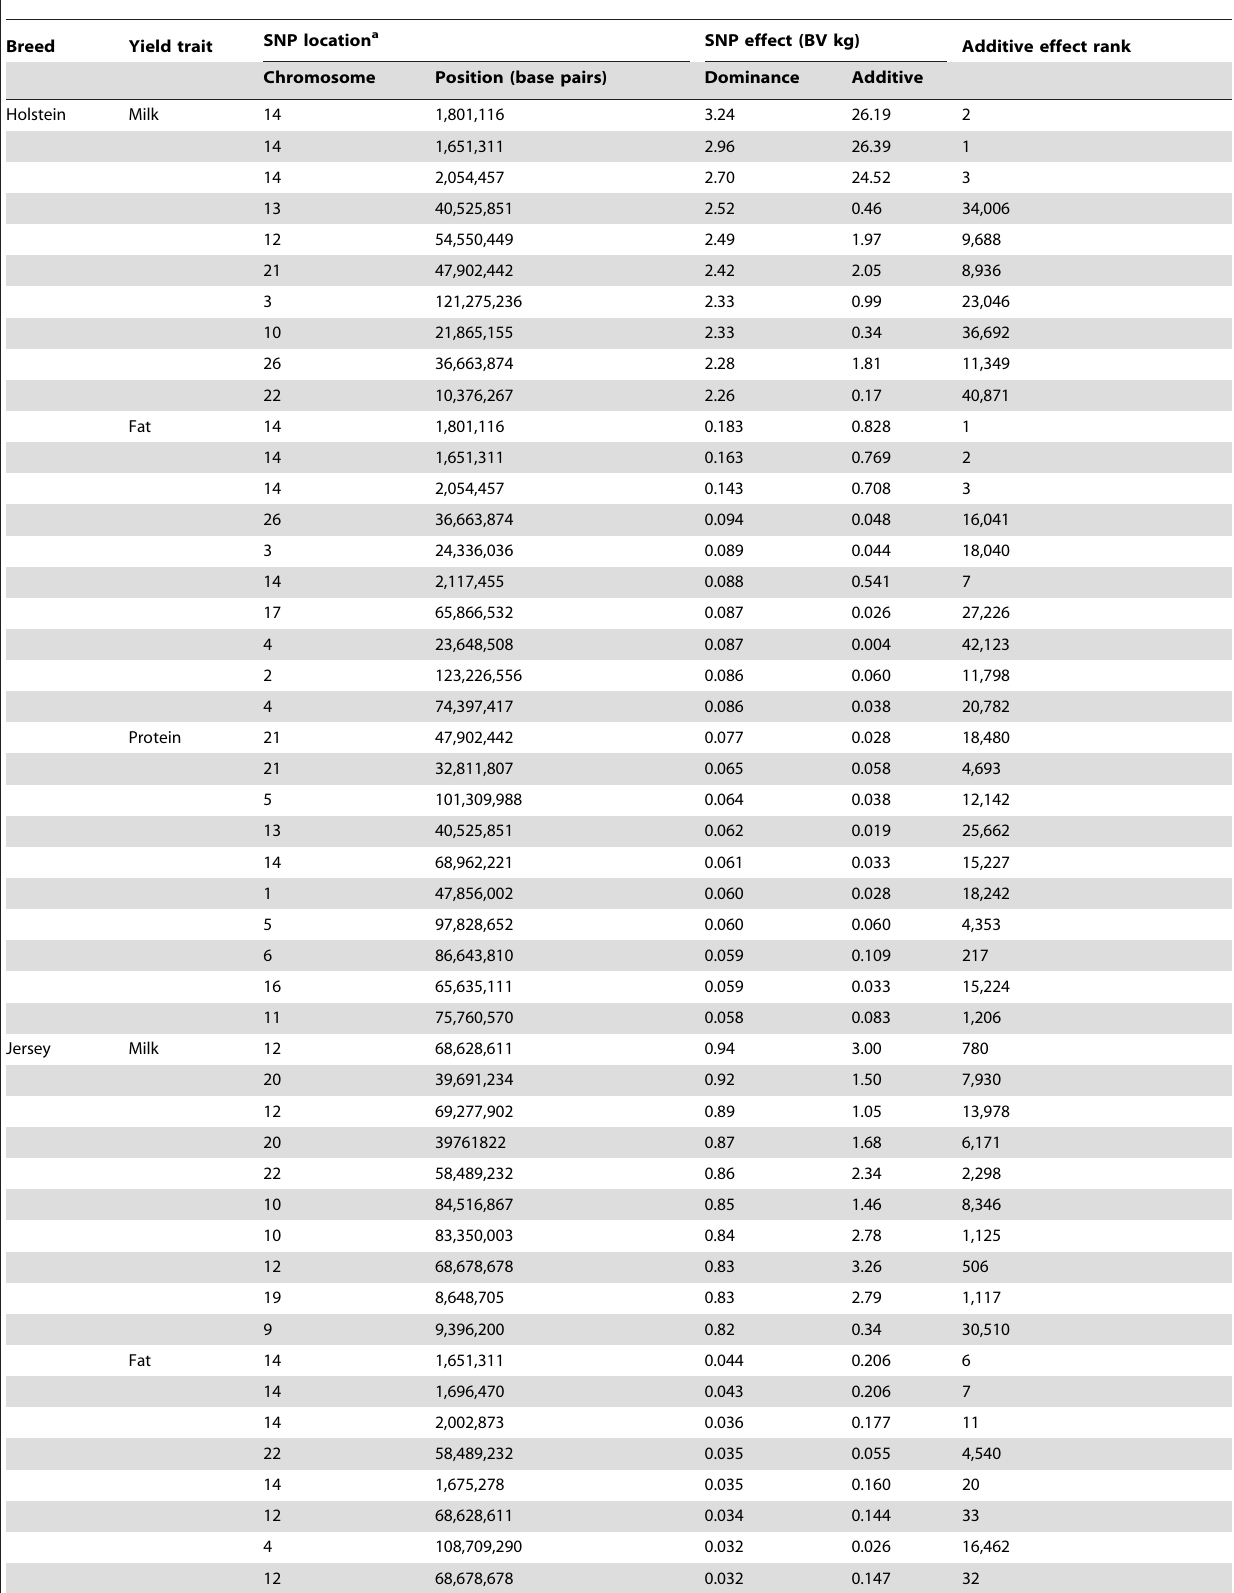
Table 7. Characteristics of top ten single nucleotide polymorphisms for Holstein and Jersey milk, fat, and protein yields based on size of dominance effect from a model with additive and dominance (values) effects